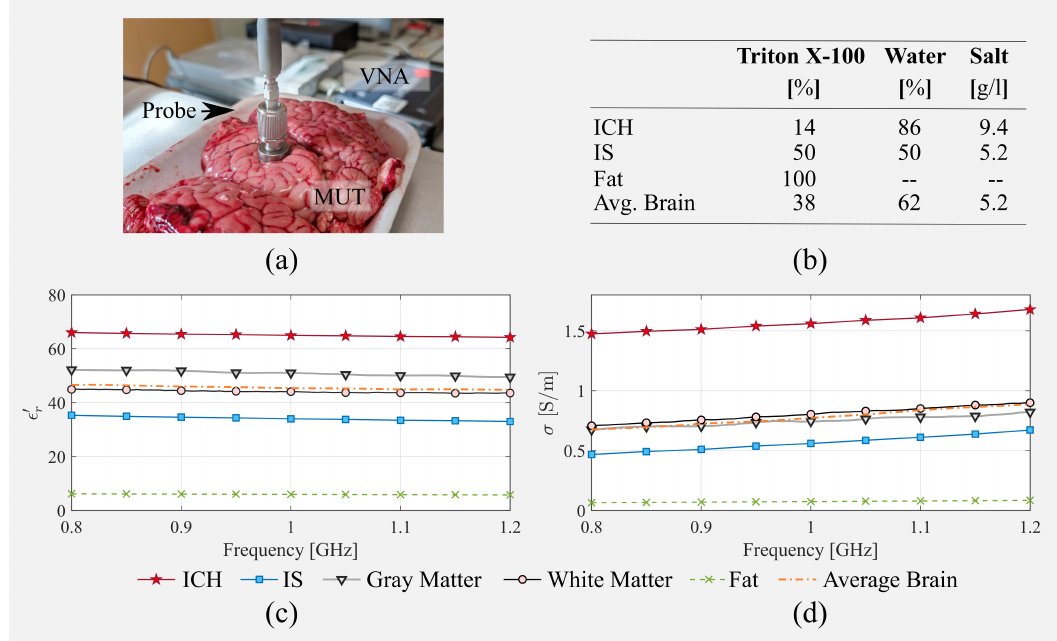
Figure 4. Dielectric properties characterization: ( a ) experimental setup, ( b ) tissue-mimicking liquid composition, ( c ) relative permittivity, and ( d )